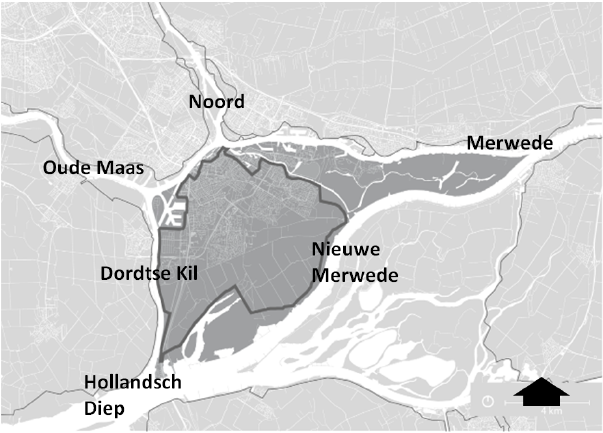
Fig. 3. Rivers and canals surrounding the Island of